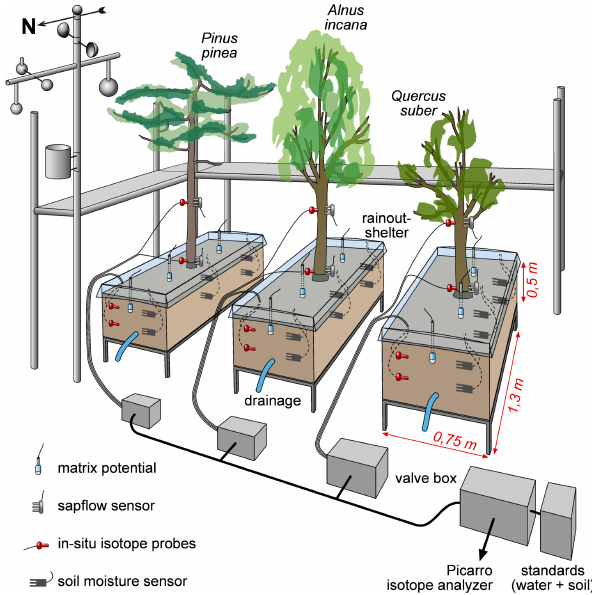
Figure 1. Experiment setup including used sensors and probes as well as the valve and tube setup for the stable water isotope probes. Trees were exposed to outdoor conditions except for natural rainfall, which was to prevent unknown water input into the soil. Note that scales for tree heights or equipment are not representative. Table 1. Characteristics of the soil used for the experiment. Note that grain size distribution was analyzed after removing the carbon- ate content with hydrochloric